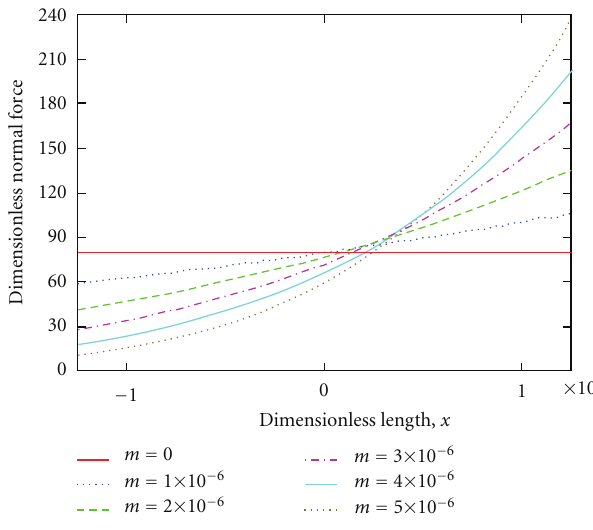
Figure 11: Dimensionless normal force, I N , versus x for h 0 = 1, β s = 500, and a =